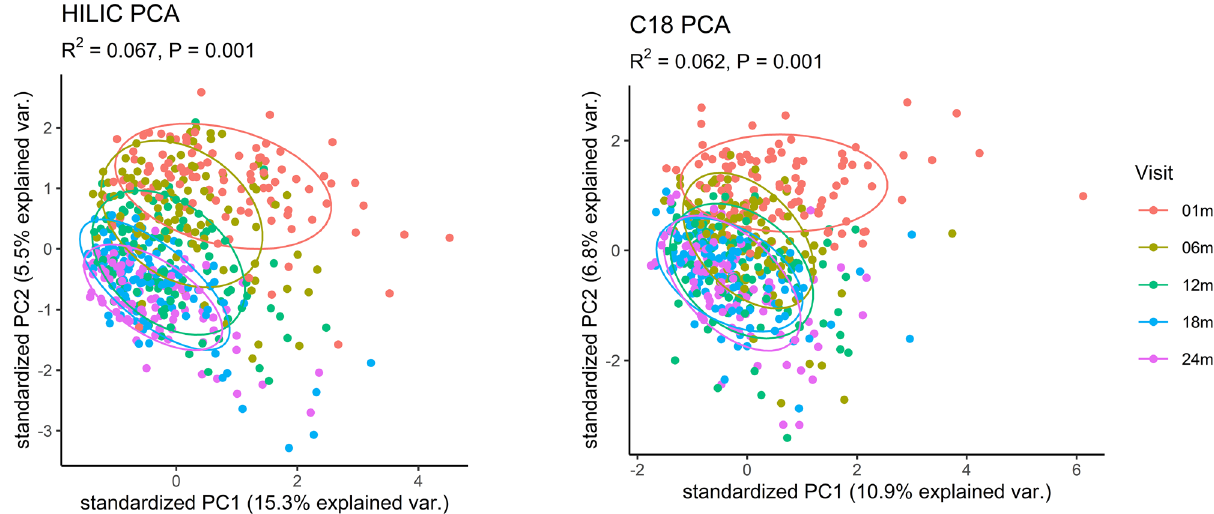
Figure 4. Ordination plot of principal components 1 and 2 for confirmed metabolites detected in HILIC (left) and C18 (right) by infant age in days. R 2 - and P - values calculated using Permutational Multivariate Analysis of Variance, with age in days as the explanatory variable. Points are colored by visit, with the age in days corresponding with each visit as follows: 01 m (25–46 days), 06 m (164–219 days), 12 m (351–429 days), 18 m (517–582 days), and 24 m (709–916 days).